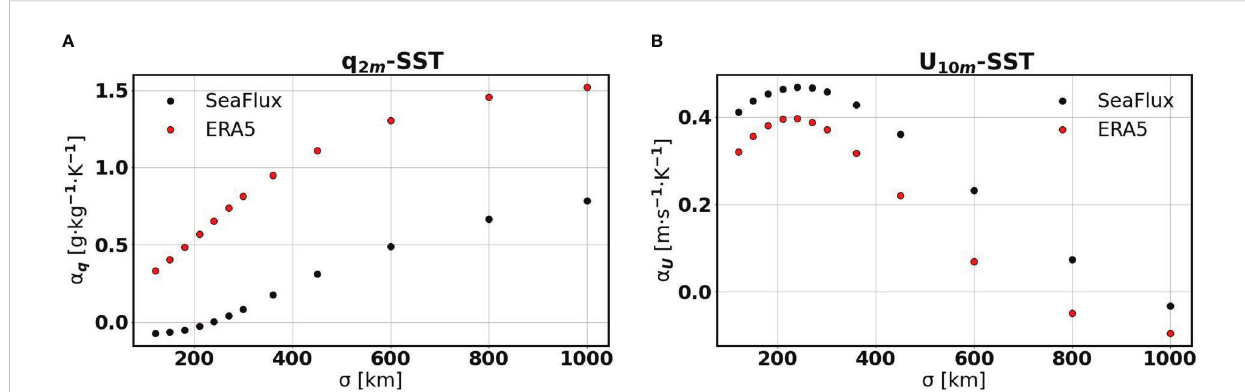
FIGURE 4 DJF coupling coef fi cients computed from SeaFlux (black dots) and ERA5 (red dots) residual fi elds as a function of s using a constant autocorrelation length of 150 km for spatial sub-sampling. (A) represents a q and (B) stands for a U . The time period considered is the DJF season 2008-2018 in all the cases and the slopes are computed considering the whole EUREC 4 A-OA region. No error bars are included as the standard errors associated to the linear regression slopes are within the size of the